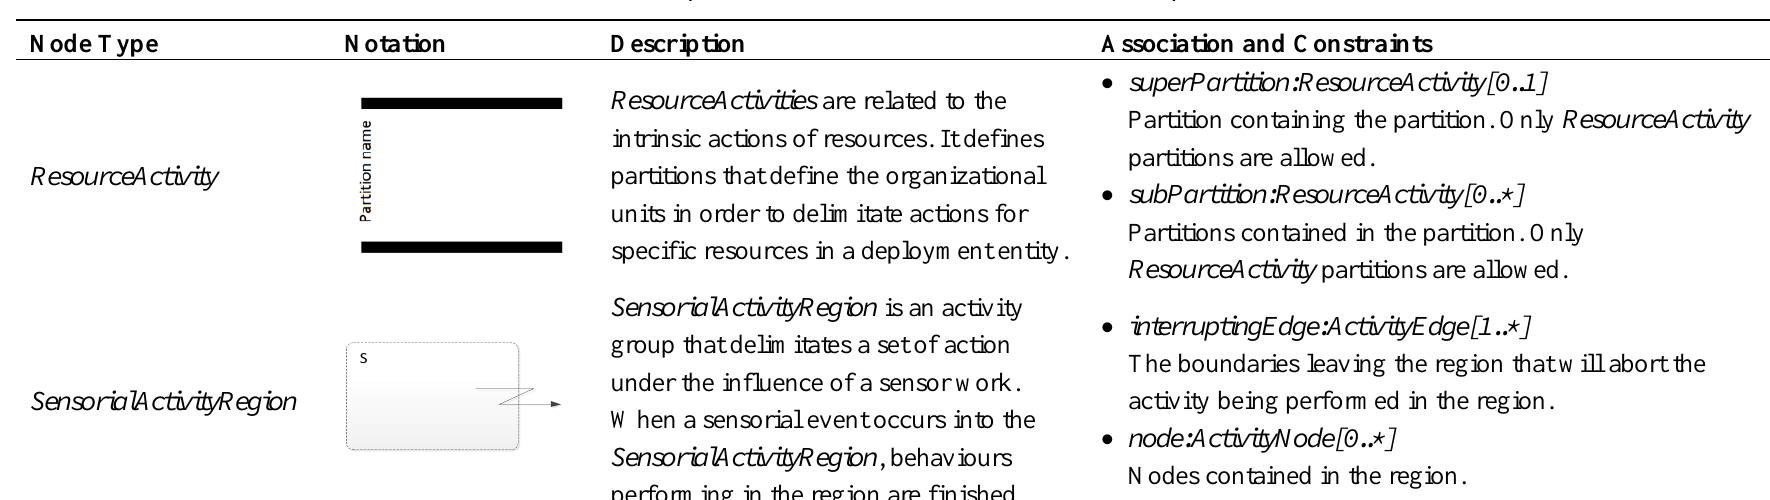
Table 4. Graphic elements for containment in SsML